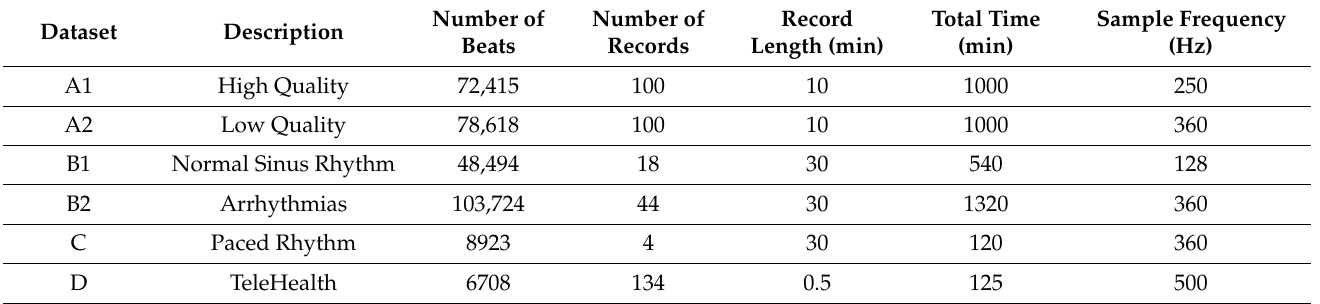
Table 1. Number of beats, number of records, record length, total time, and sampling frequency by